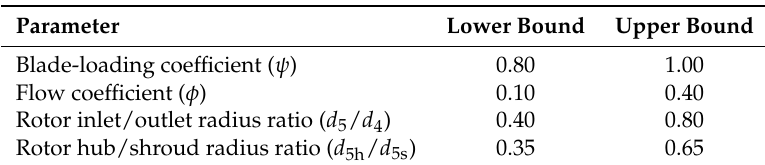
Table 4. Bounds for the turbine optimisation study.